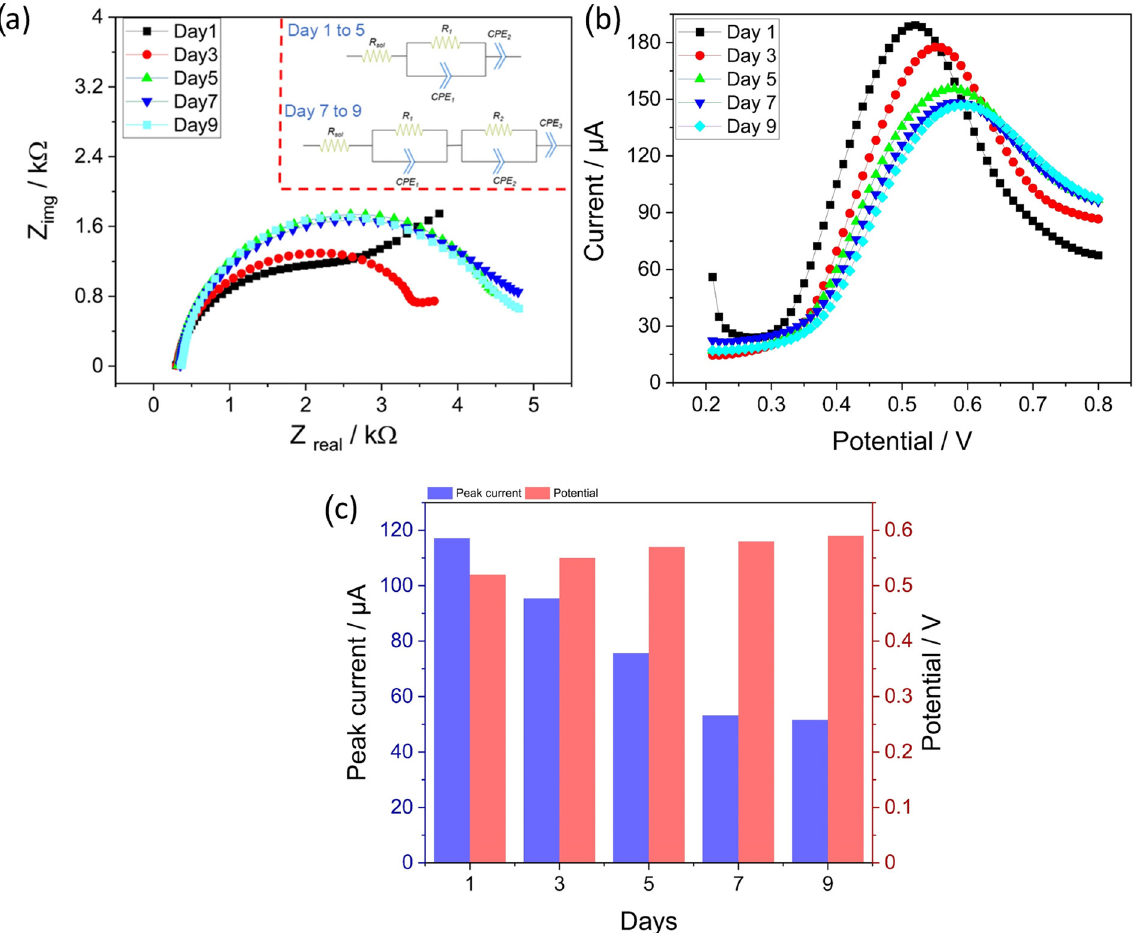
Figure 10. ( a ) EIS spectra of EdAu/SPCE electrode with respect to the days and the inset shows the equivalent circuit, ( b ) shows the corresponding SWV measurements, and 10 ( c ) Bar graph showing the variation in peak potential and peak currents obtained from SWV.